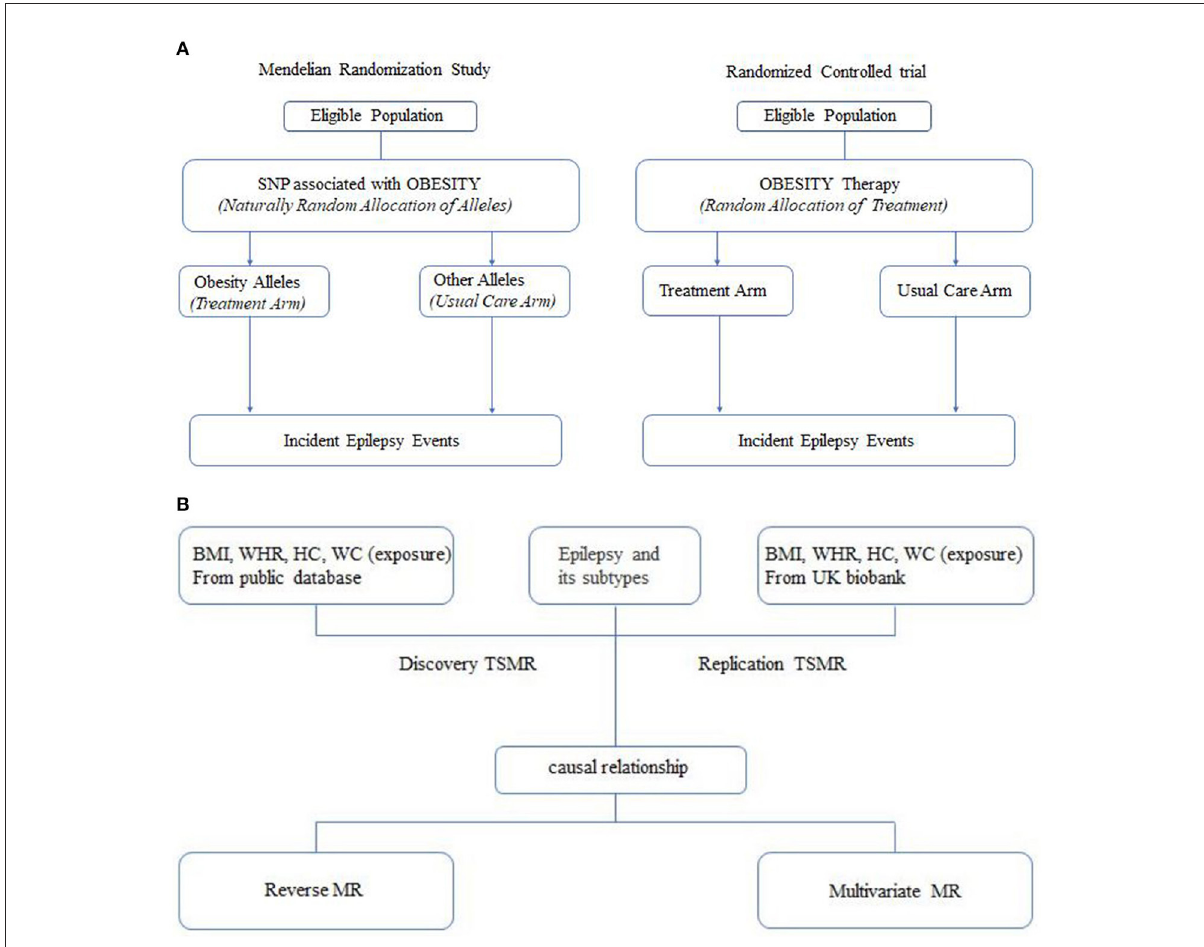
FIGURE1 (A) Analogy between a mendelian randomization study and a randomized trial. (B) Flow